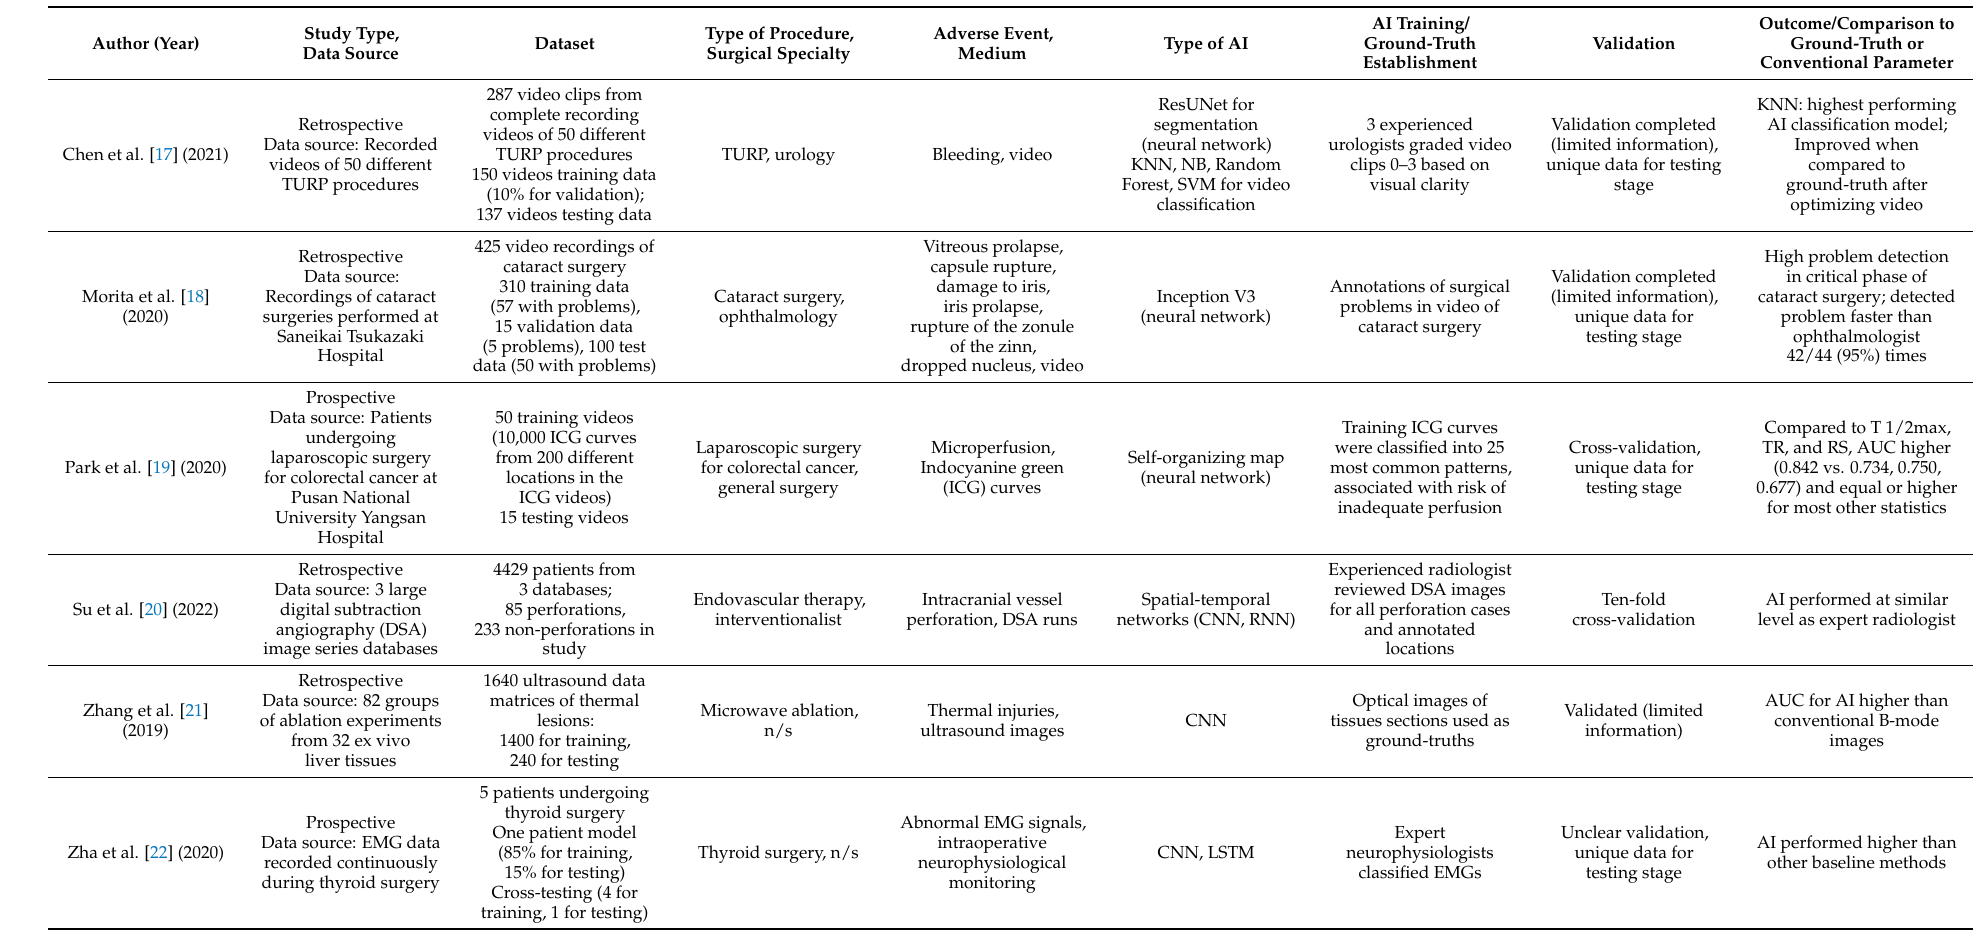
Table 1. Summary of the 13 included